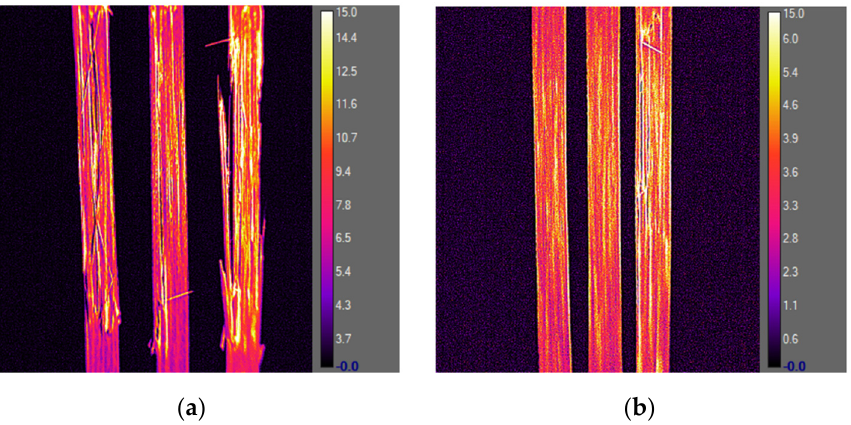
Figure 16. ( a ) Damaged specimens − annealed continuous FRP, 0°; ( b ) damaged specimens − raw con- tinuous FRP, 0°.